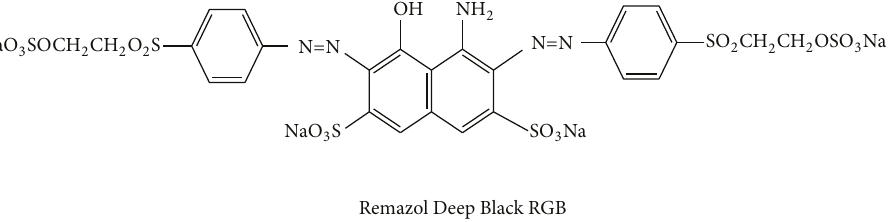
Scheme 1: The structure of RDB